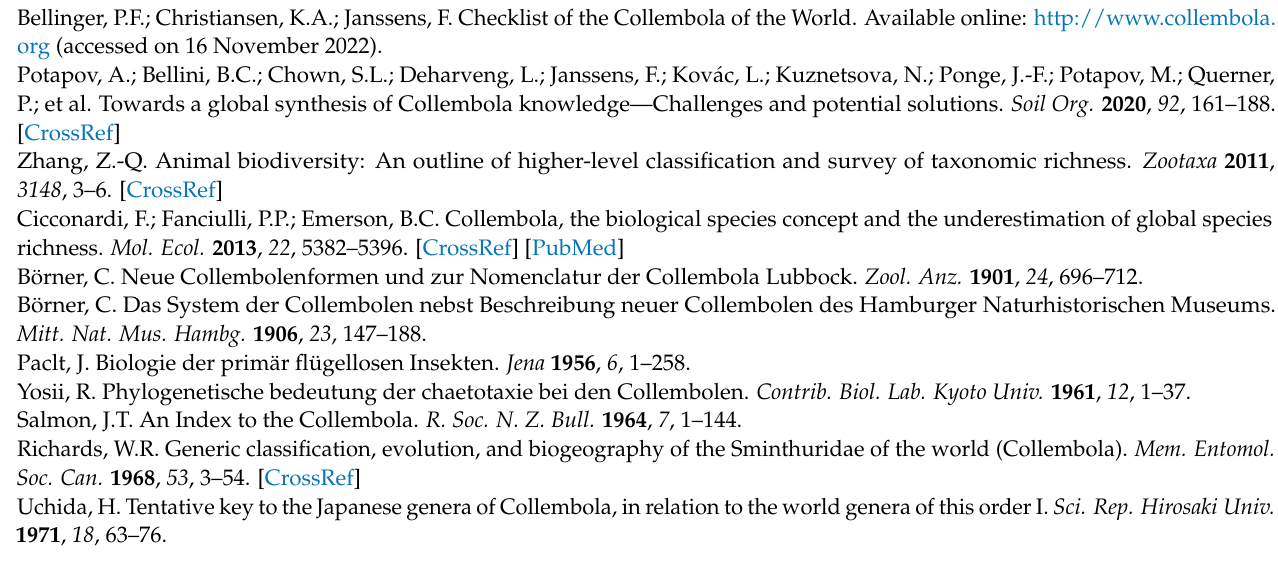
Table S1: Taxonomic information, GenBank accession numbers, country and information source of all analyzed species; Table S2: Partitioning scheme and substitution models selected by Model Finder used for partitioned maximum likelihood analyses. Table S3: Tree topology tests of non monophyletic groups of Collembola higher